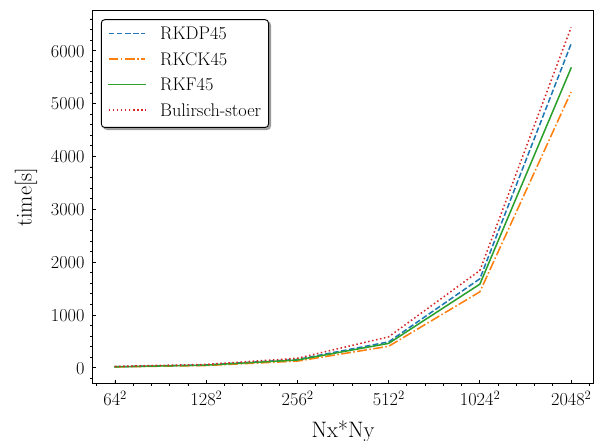
Fig. 8 Computational time (time machine in seconds) for all the inte- gration schemes as a function of the numerical resolution